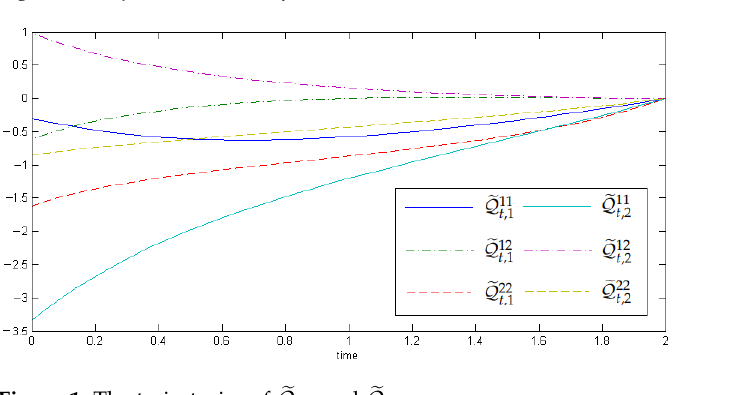
Figure 1. The trajectories of (cid:101) Q t ,1 and (cid:101) Q t ,2 .